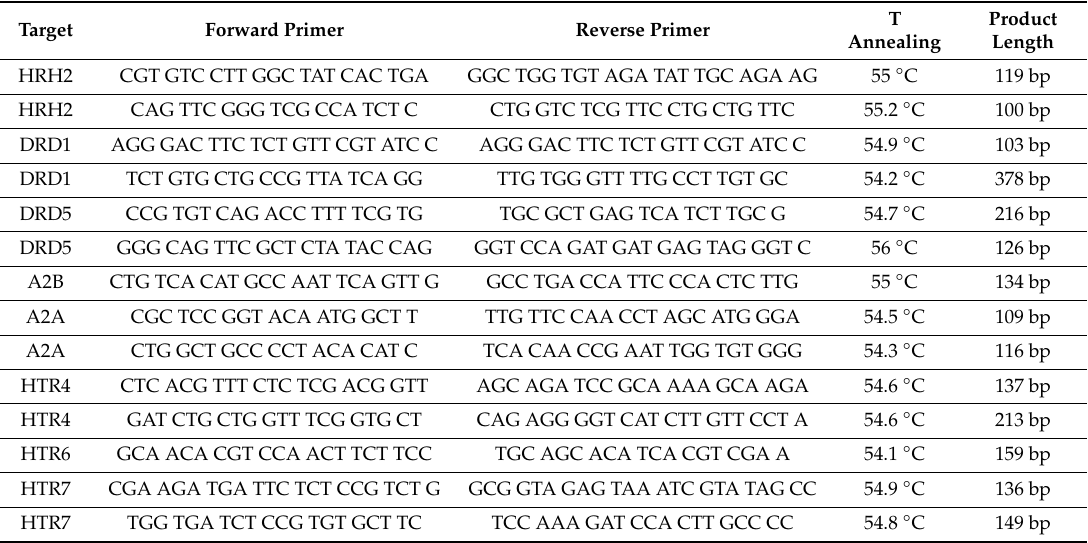
Table 1. Primers used for receptors expression